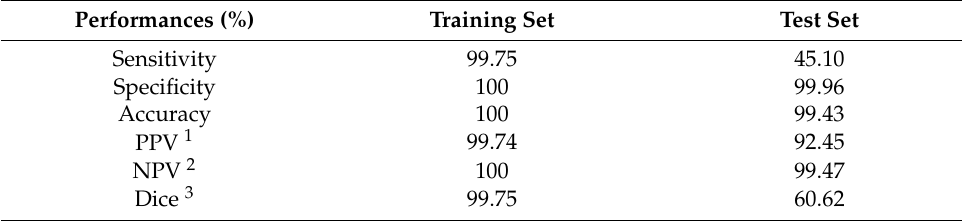
Table 2. Results of automatic segmentation using 3D U-Net.